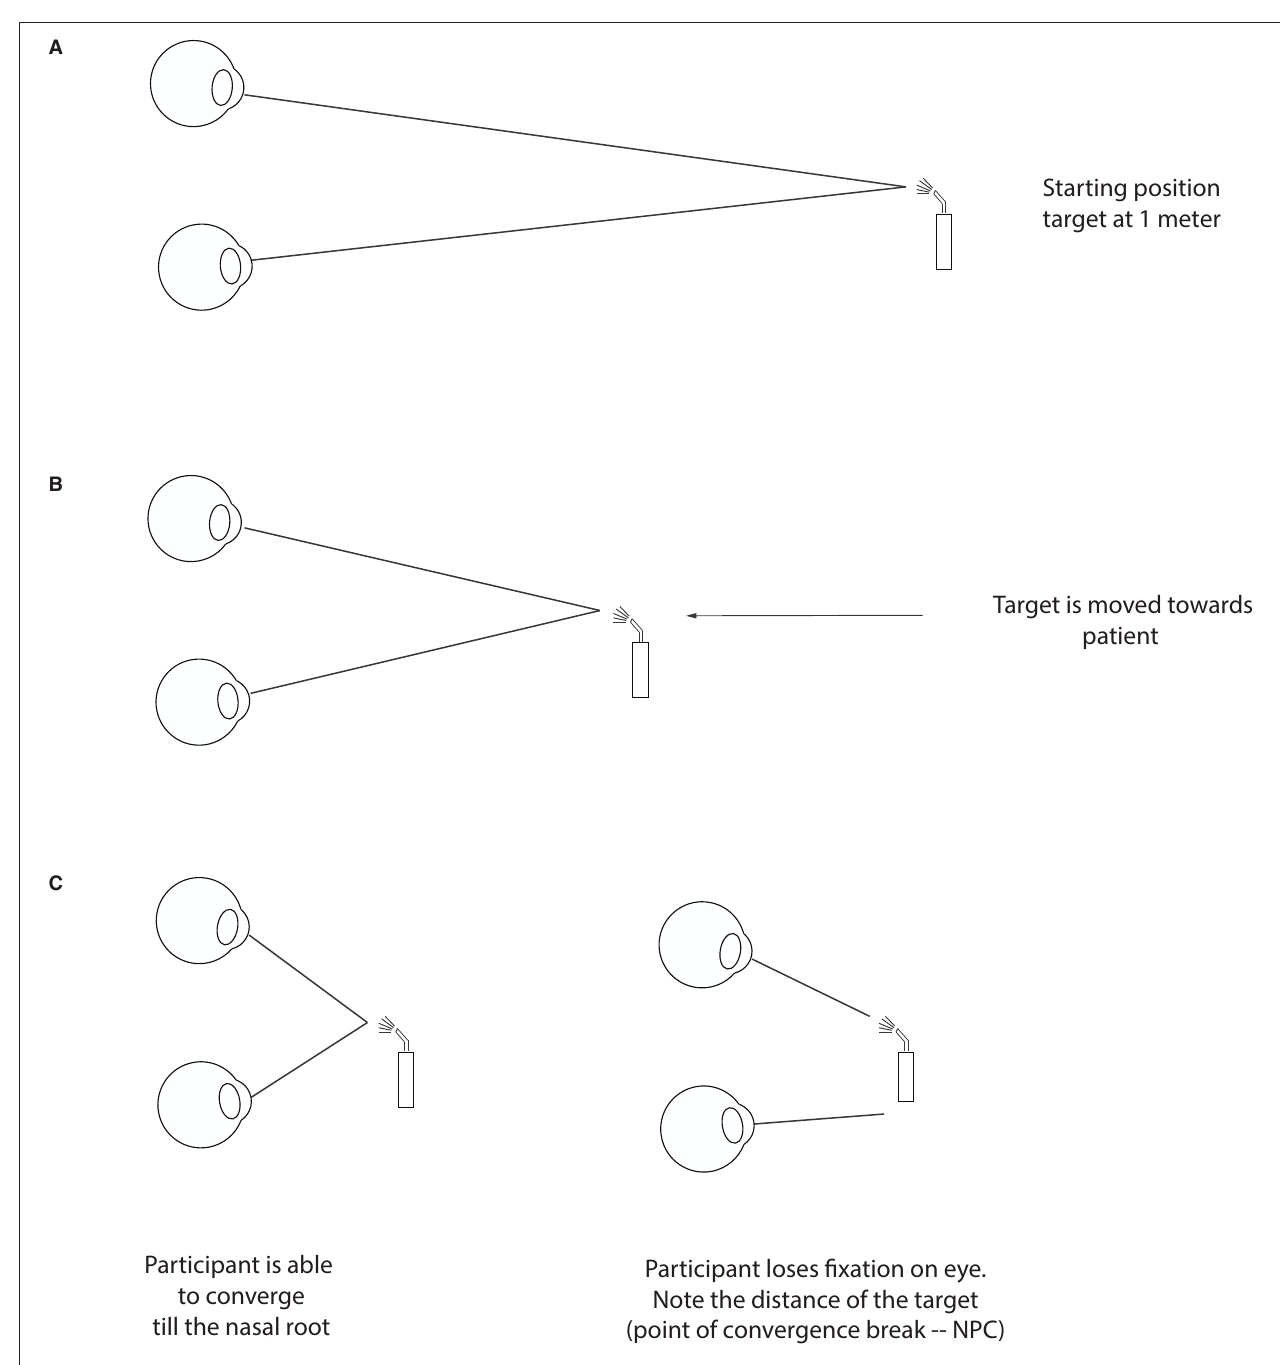
FIGURE 3 | Testing for convergence insufficiency. At the starting position, a target is placed roughly at 60cm from the patient (about armlength), slightly below the midline (A) . The target is then moved slowly and steadily forward toward the bridge of the patient’s nose and clear instructions are given to report double vision (B) . In the process, the patient will either maintain fixation until their nose or lose fixation (one eye will deviate) at the point of convergence break. The distance at which this break happens (or when the patient reports seeing double) is the NPC and is noted in cm (C) .